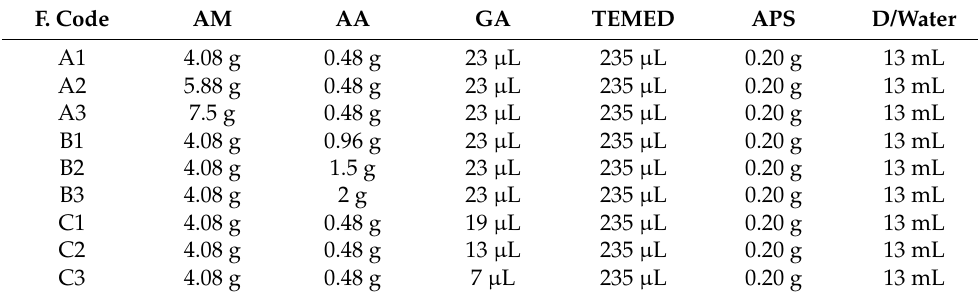
Table 5. Composition of formulated